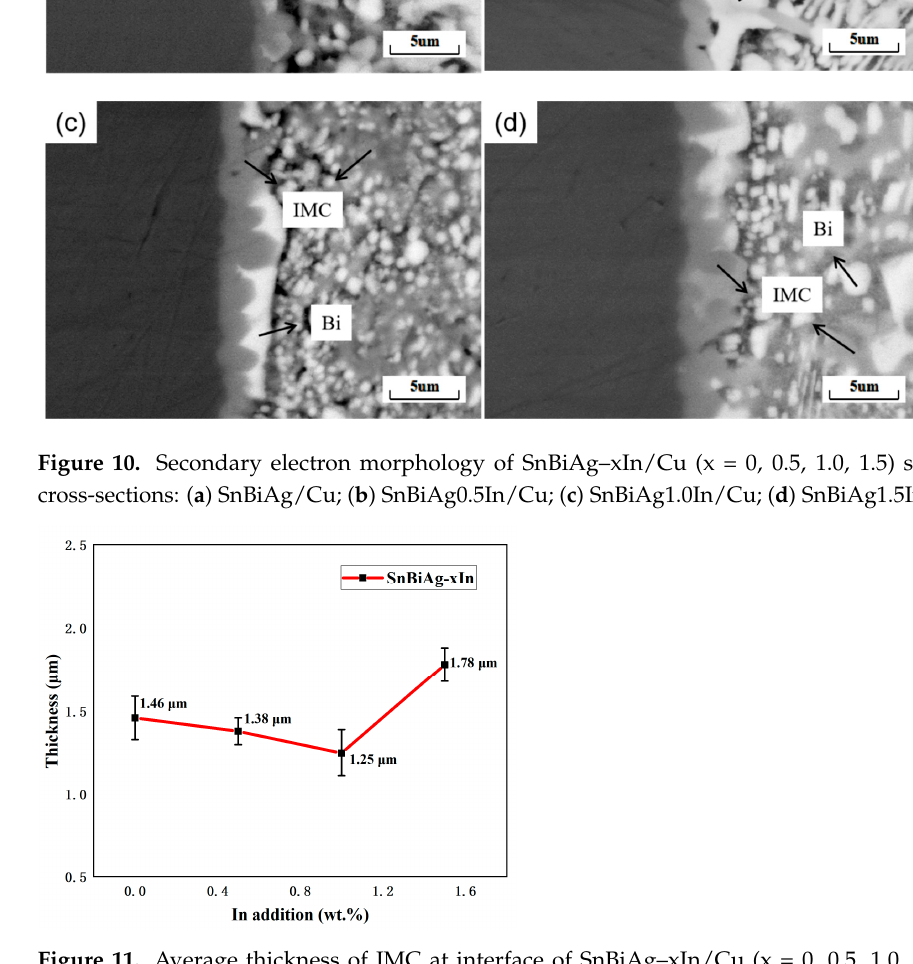
Figure 11. Average thickness of IMC at interface of SnBiAg–xIn/Cu (x = 0, 0.5, 1.0, 1.5) solder joints: 1.46 µ m—SnBiAg/Cu; 1.38 µ m—SnBiAg0.5In/Cu; 1.25 µ m—SnBiAg1.0In/Cu; 1.78 µ m—SnBiAg1.5In/Cu.